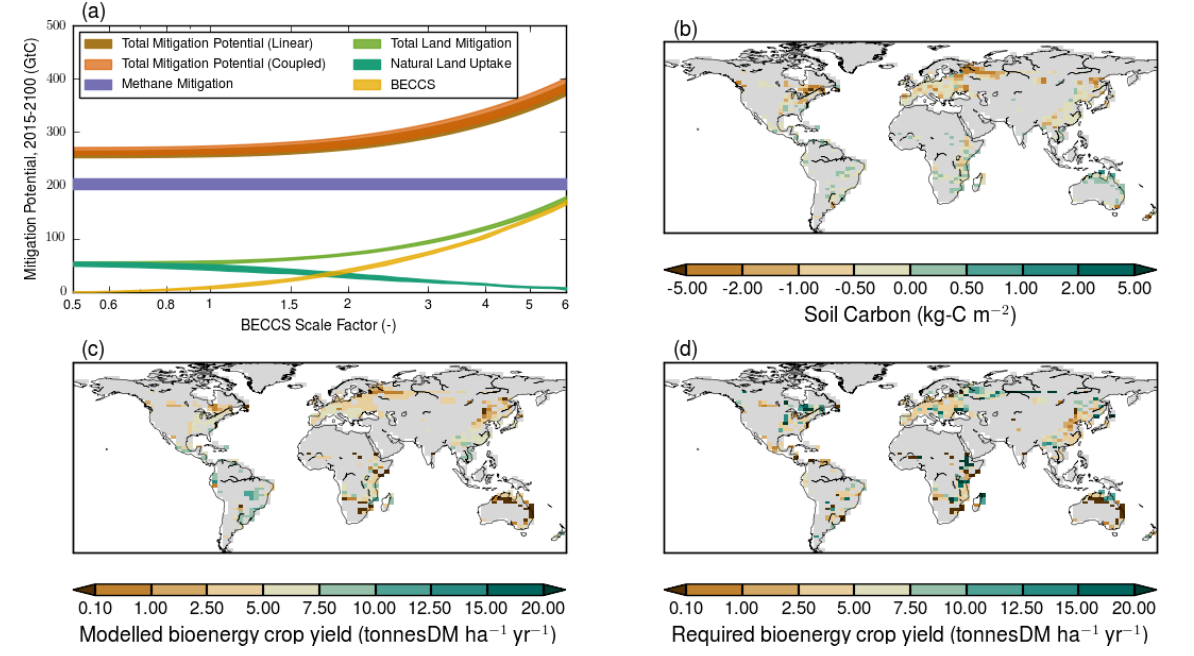
Figure 10. (a) The total and component mitigation potential (GtC) for different mitigation options, involving methane and land use, as a function of the BECCS efficiency factor ( κ , Sect. 2.4.3) for the temperature pathway reaching 1.5 ◦ C. The width of the lines represent the interquartile range of the 136-member ensembles. Maps of (b) the change of the modelled soil carbon (kgCm − 2 ) between 2015 and 2099, as the difference between the scenario with BECCS and the natural land-management scenario; (c) the modelled mean bioenergy crop yield in the JULES simulations ( κ = 1); and (d) the required bioenergy crop yield for BECCS to provide a larger carbon uptake than forest regrowth and afforestation (assuming κ = κ ∗ and 87% efficiency of BECCS). Grid cells that do not exceed 1% BECCS cover for any year in the simulation are masked